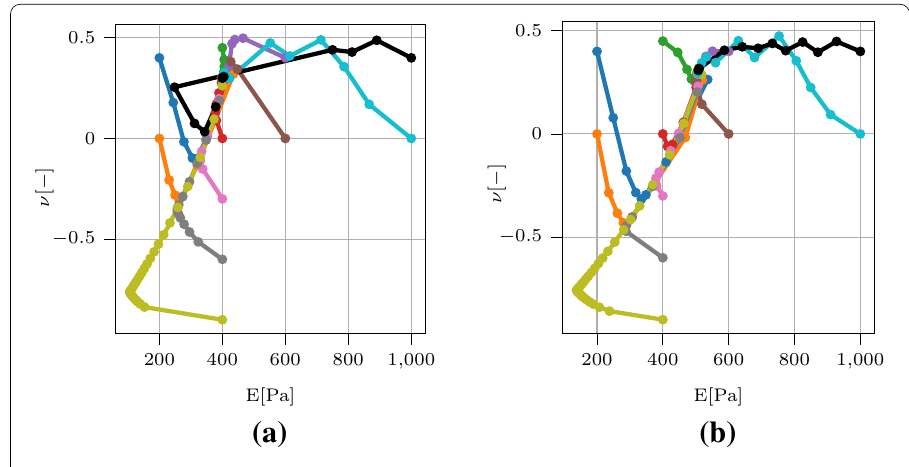
Fig. 4 Path in parameters space towards optimum for data sets a without noise and b with Gaussian noise with standard deviation σ = 10 − 2 mm added to the measurements with one marker per iteration